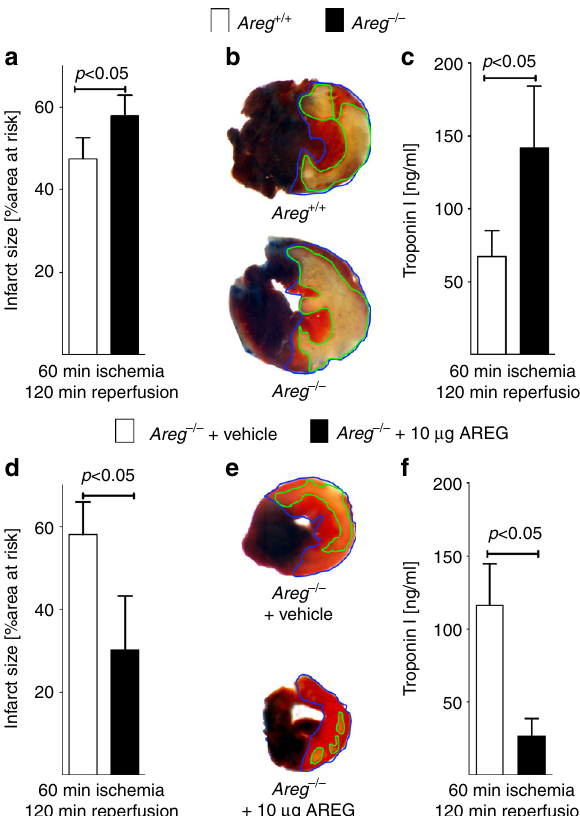
Fig. 5 Myocardial tissue injury in Areg − / − mice exposed to myocardial ischemia and reperfusion injury. a – f Experimental animals were exposed to 60 min of myocardial ischemia, followed by 120 min of reperfusion; infarct sizes were measured by double staining with Evan ’ s blue and triphenyltetrazolium chloride and serum samples were collected. All infarct sizes are presented as the percentage of infarcted tissue in relation to the area-at-risk. Serum troponin levels were determined by ELISA ( a ). Infarct sizes were determined in gene-targeted mice for amphiregulin ( Areg − / − mice) or isogenic control animals ( Areg + / + mice) ( n = 5 per group). b Representative infarct staining from Areg − / − or Areg + / + . c Troponin serum levels in Areg − / − or Areg + / + mice ( n = 5 per group). d Reconstitution of Areg − / − mice with recombinant AREG. Infarct sizes in Areg − / − treated with vehicle or 10 μ g of recombinant murine Areg, administered over 15 min period by an indwelling catheter ( n = 6 per group). e Representative infarct staining from Areg − / − mice treated with vehicle or 10 µ g recombinant murine Areg. f Troponin serum levels after myocardial IR injury of Areg − / − mice treated with vehicle or 10 µ g recombinant murine Areg via an intraarterial catheter over a 15 min period ( n = 7 per group). All data presented as mean ± SD. Statistical signi fi cance assessed by two-sided, unpaired Student ’ s t